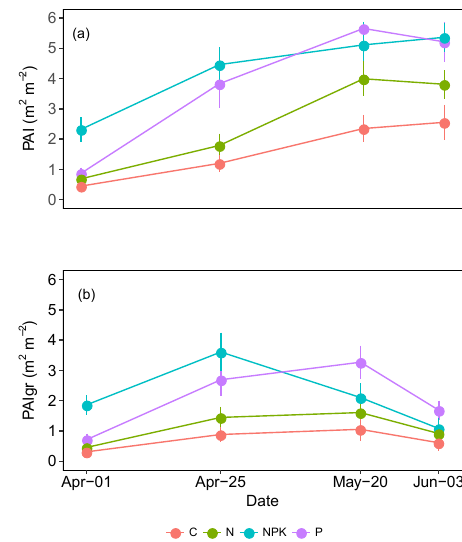
Figure 2. Average green plant area index (PAI) and the green frac- tion of PAI (PAIgr) observed in grasslands subjected to different fertilization treatments (C, N, NPK or P). Each point is the average of six replicates. Vertical bars represent error bars. Table 3. Percentage of each plant functional type (Forbs, Graminoids and Legumes) in above-ground biomass of grasslands under different fertilization treatments (C, N, NPK and P). Val- ues represent means of six replicates; standard errors are shown in